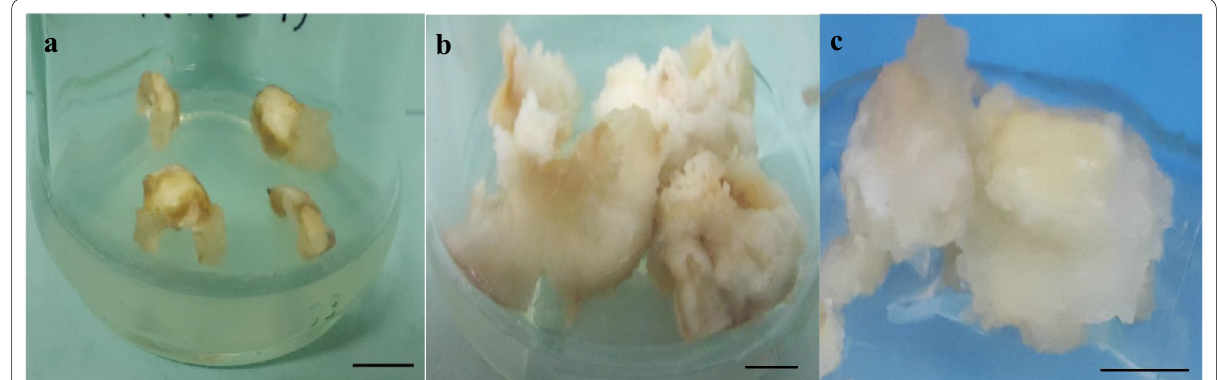
Fig. 1 In vitro callogenesis from nut explants of Corylus avellana . Initiation of callus formation from explants ten days after culture ( a ); Callus growth from explants exposed to 1 min US and cultured on ½ MS medium containing 2 mg/L 2,4‑D and 0.2 mg/L Kin ( b ); and B5 medium containing 2 mg/L 2,4‑D and 0.2 mg/L Kin ( c ); (Scale bars 1 =